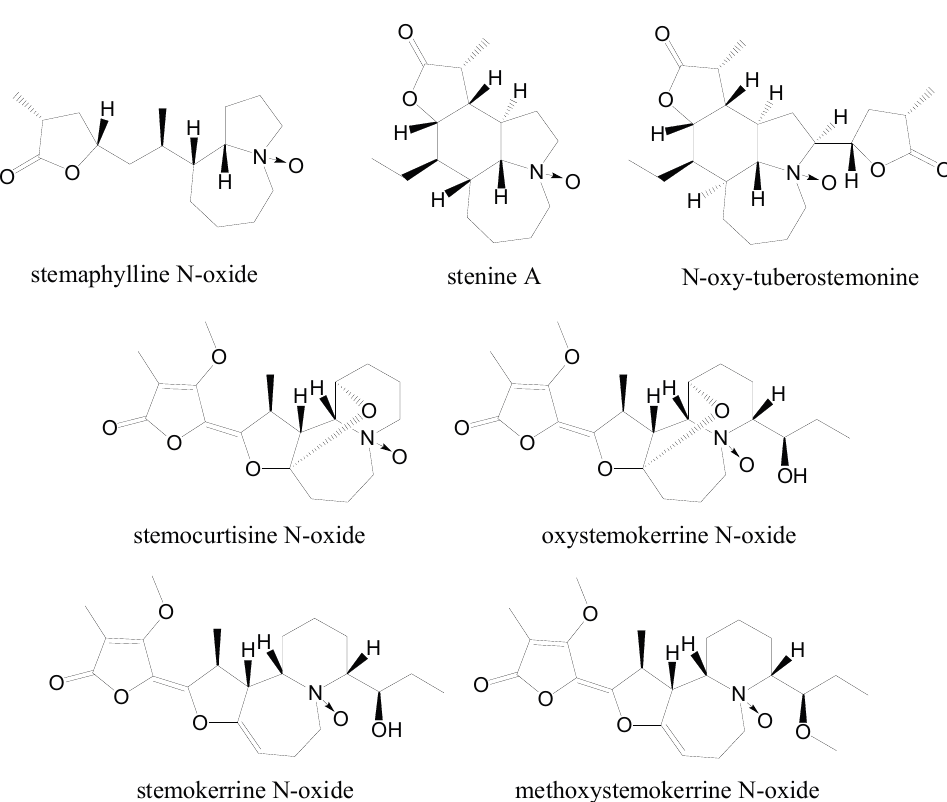
Figure 3. N-oxide Stemona